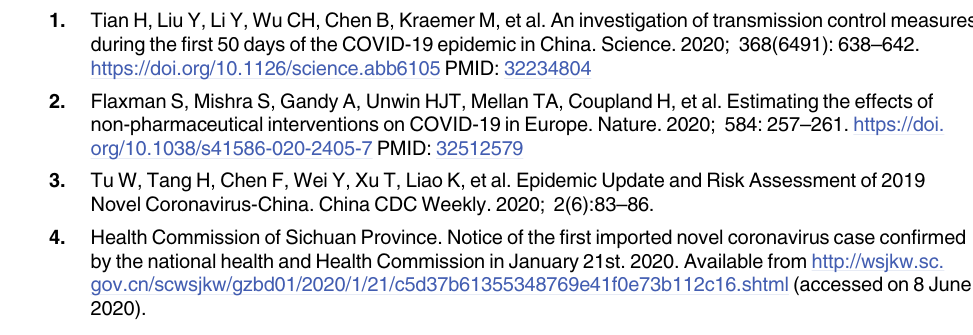
S1 Table. Total number of COVID-19 confirmed cases for each of the 21 prefectures of Sichuan Province of